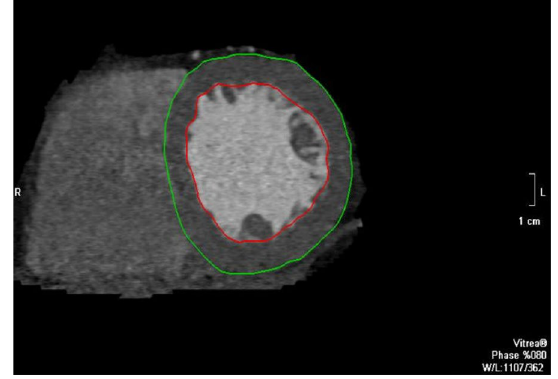
Fig. 1 Assessment of the LV mass by automatic contouring of the endocardial and epicardial borders with slight manual correction, taken at the end-diastole (80% of the cardiac cycle)